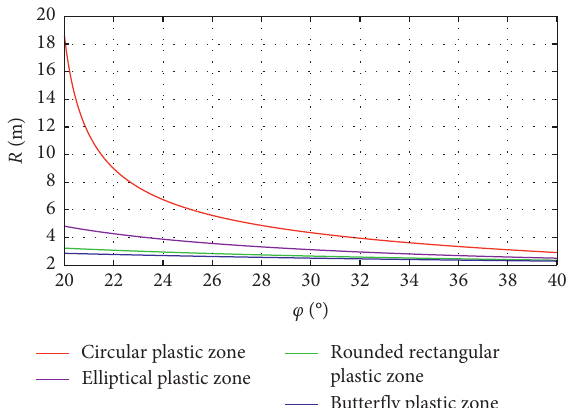
Figure 11: Variation of the radius of the plastic zone with respect to the friction